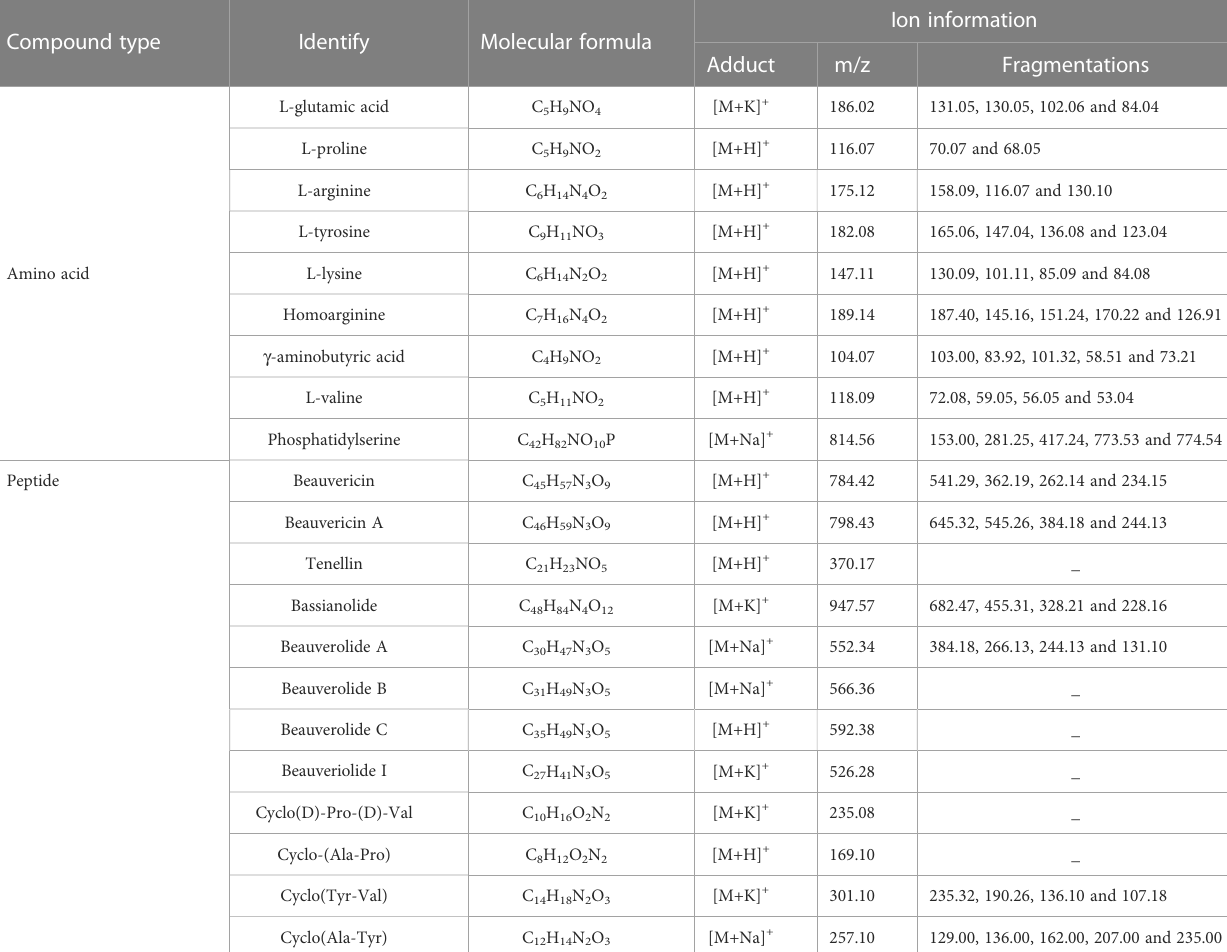
TABLE 1 Amino acids and peptides detected in Bombyx batryticatus by MALDI-TOF-MSI and con fi rmed by MALDI-TOF-MS/MS.